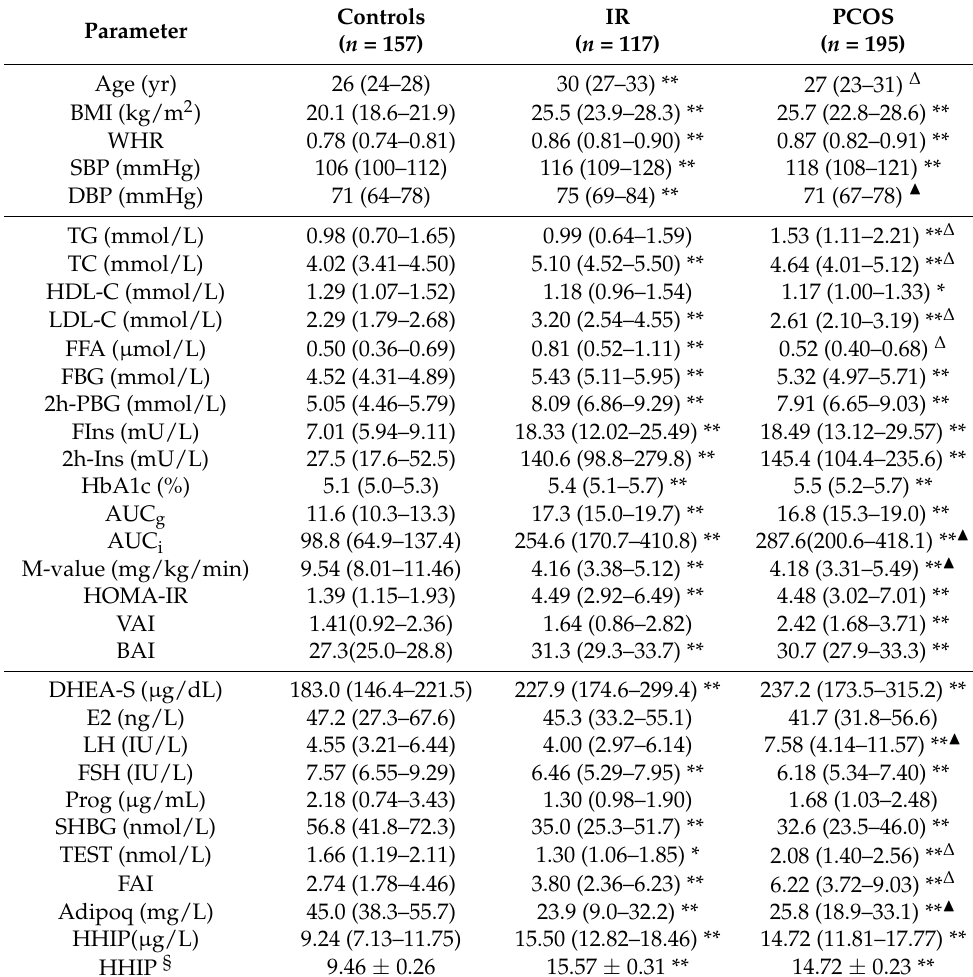
Table 1. Clinical, hormonal and metabolic parameters in the study population.